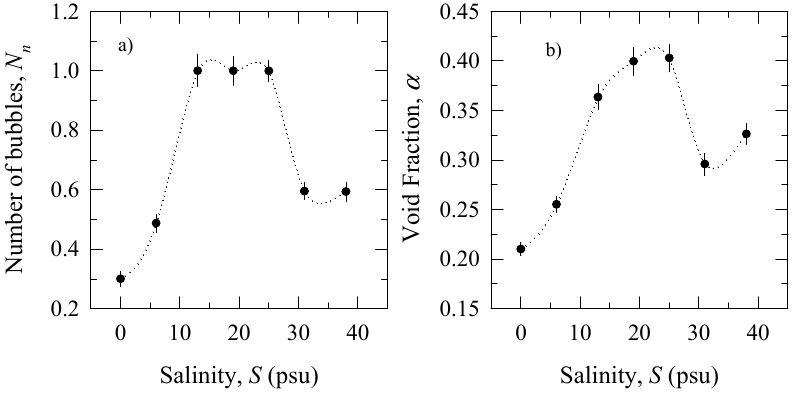
Figure 7. Salinity dependence of the: ( a ) number of bubbles within the bubble cloud (normalized to the maximum observed value); ( b ) bubble cloud void fraction.